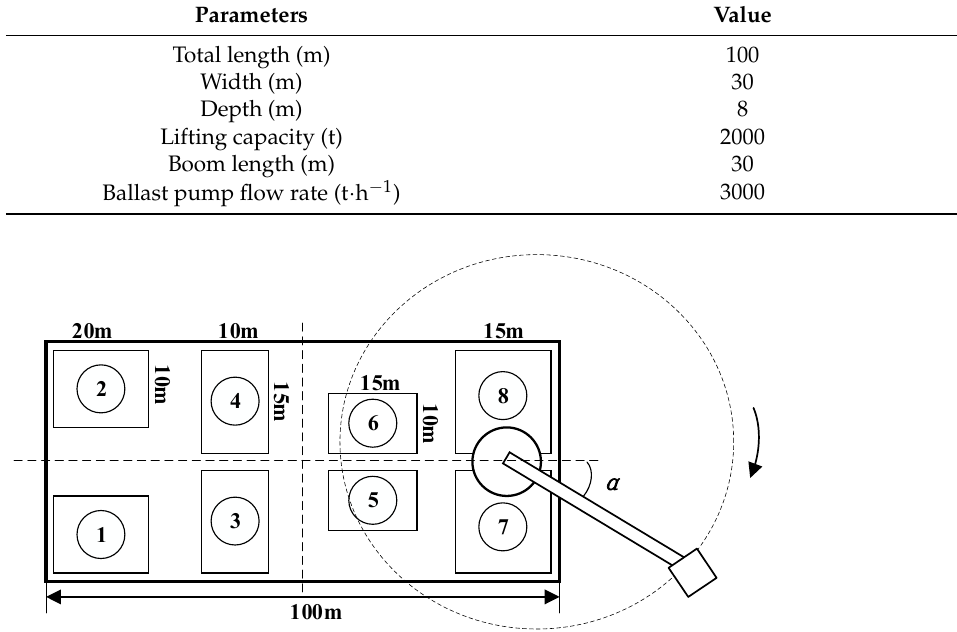
Figure 18. The ballast tank layout of the RFC with eight ballast tanks.